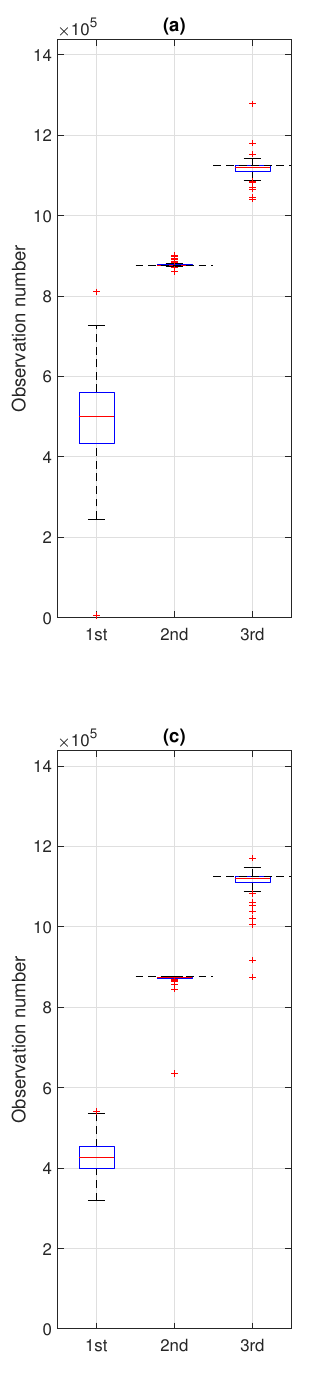
Figure 15. Boxplots presenting the results of the Monte Carlo simulation study, i.e., the identified moments of the first (purple), the second (red), and the third (yellow) regime changes for 100 simulated signals. Panel ( a ) corresponds to the procedure applied to non-overlapping windows of length 2500 (with step equal to 2500) and panels ( b ) and ( c ) correspond to the overlapping windows of length 2500 with step equal to 500 and 250, respectively. Black dash lines for the second and the third boxplot indicate the theoretical moments of σ and α stabilization,